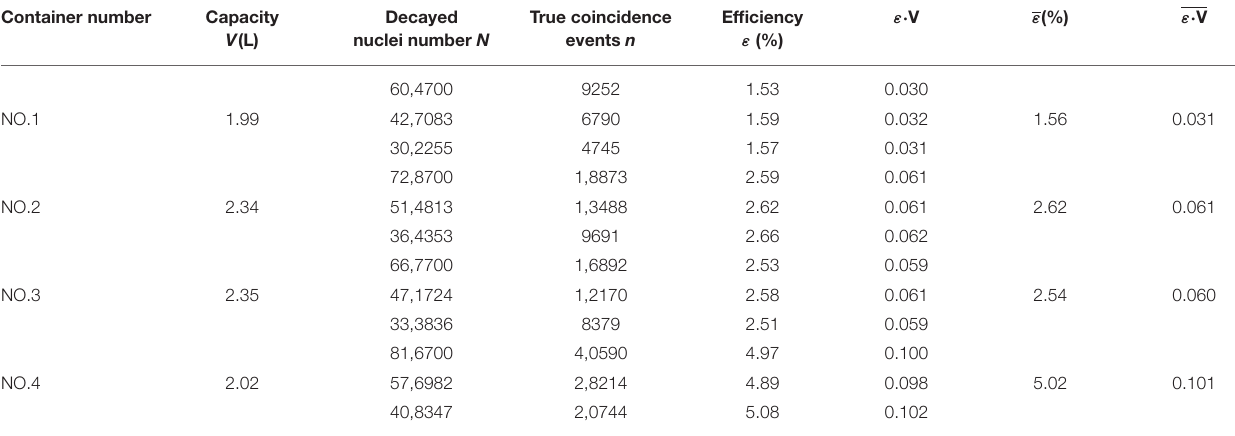
V for different arrangements of containers. •